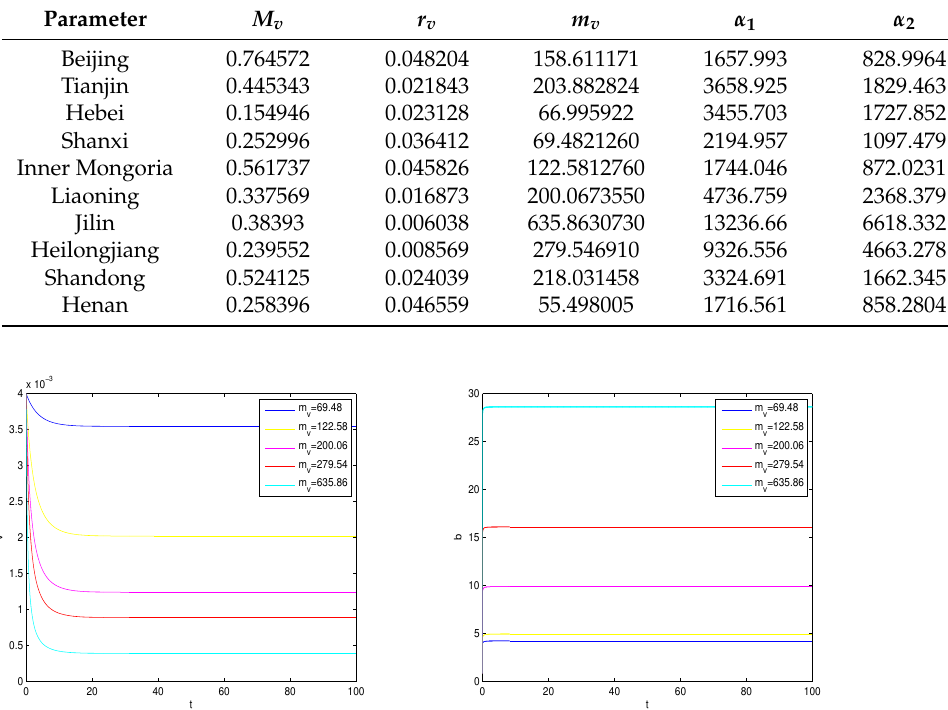
Figure 3. Effects of m v on trees and beetles. Shanxi m v = 69.48, Inner Mongoria m v = 122.58, Liaoning m v = 200.06, Heilongjiang m v = 279.54, Jilin m v = 635.86.